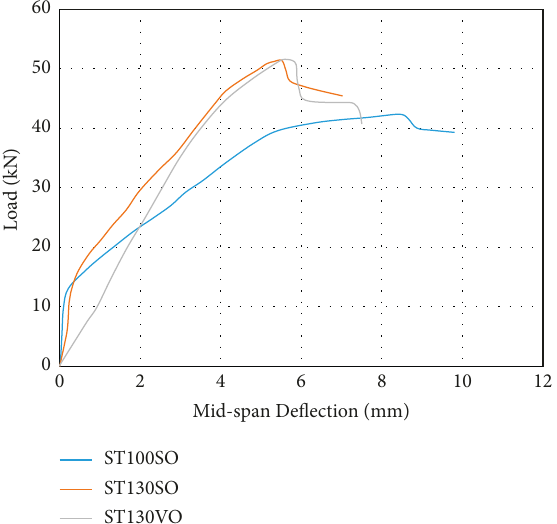
Figure 6: Comparison of voided and solid RC slabs.